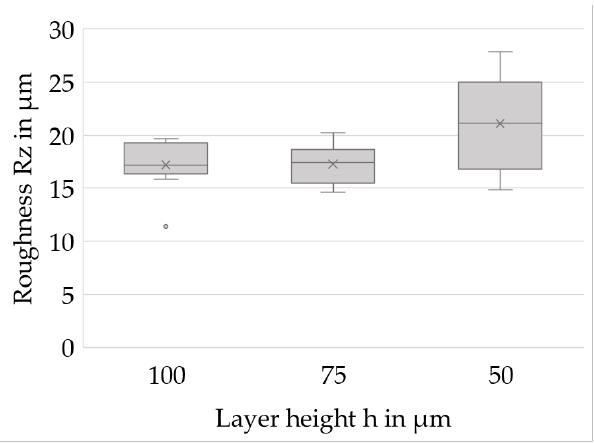
Figure 13. Average roughness depths Rz for different layer